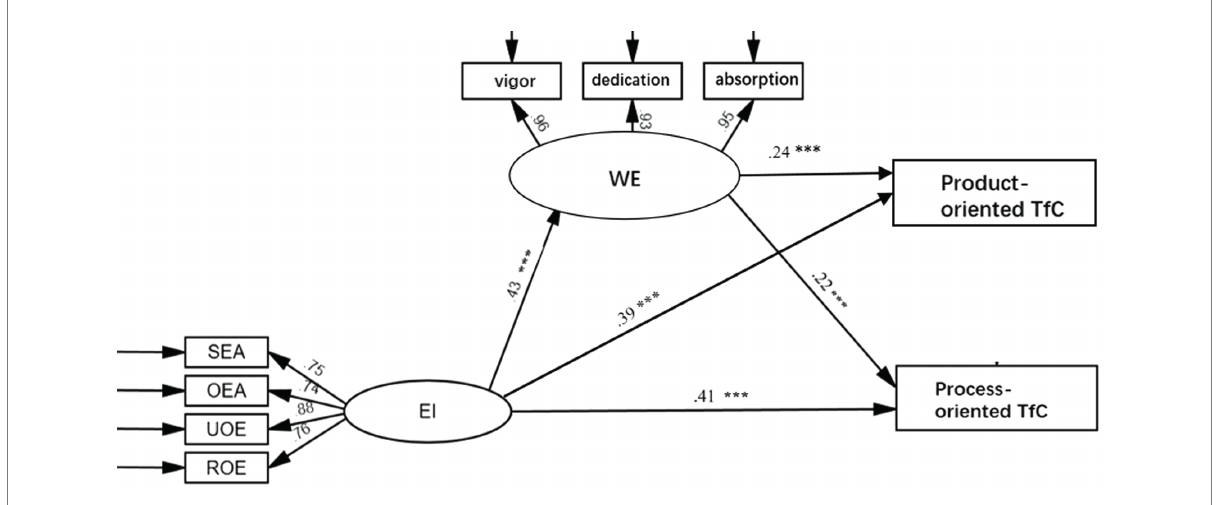
FIGURE 1 Structural model of the relationships among EI, WE and TfC. (Standardized regression weights are reported). * p < 0.05, ** p < 0.01, *** p <